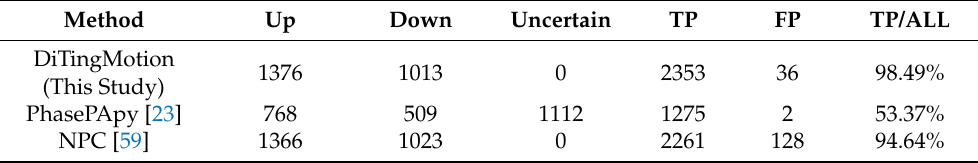
Table 1. Comparison of polarity classification results obtained with different